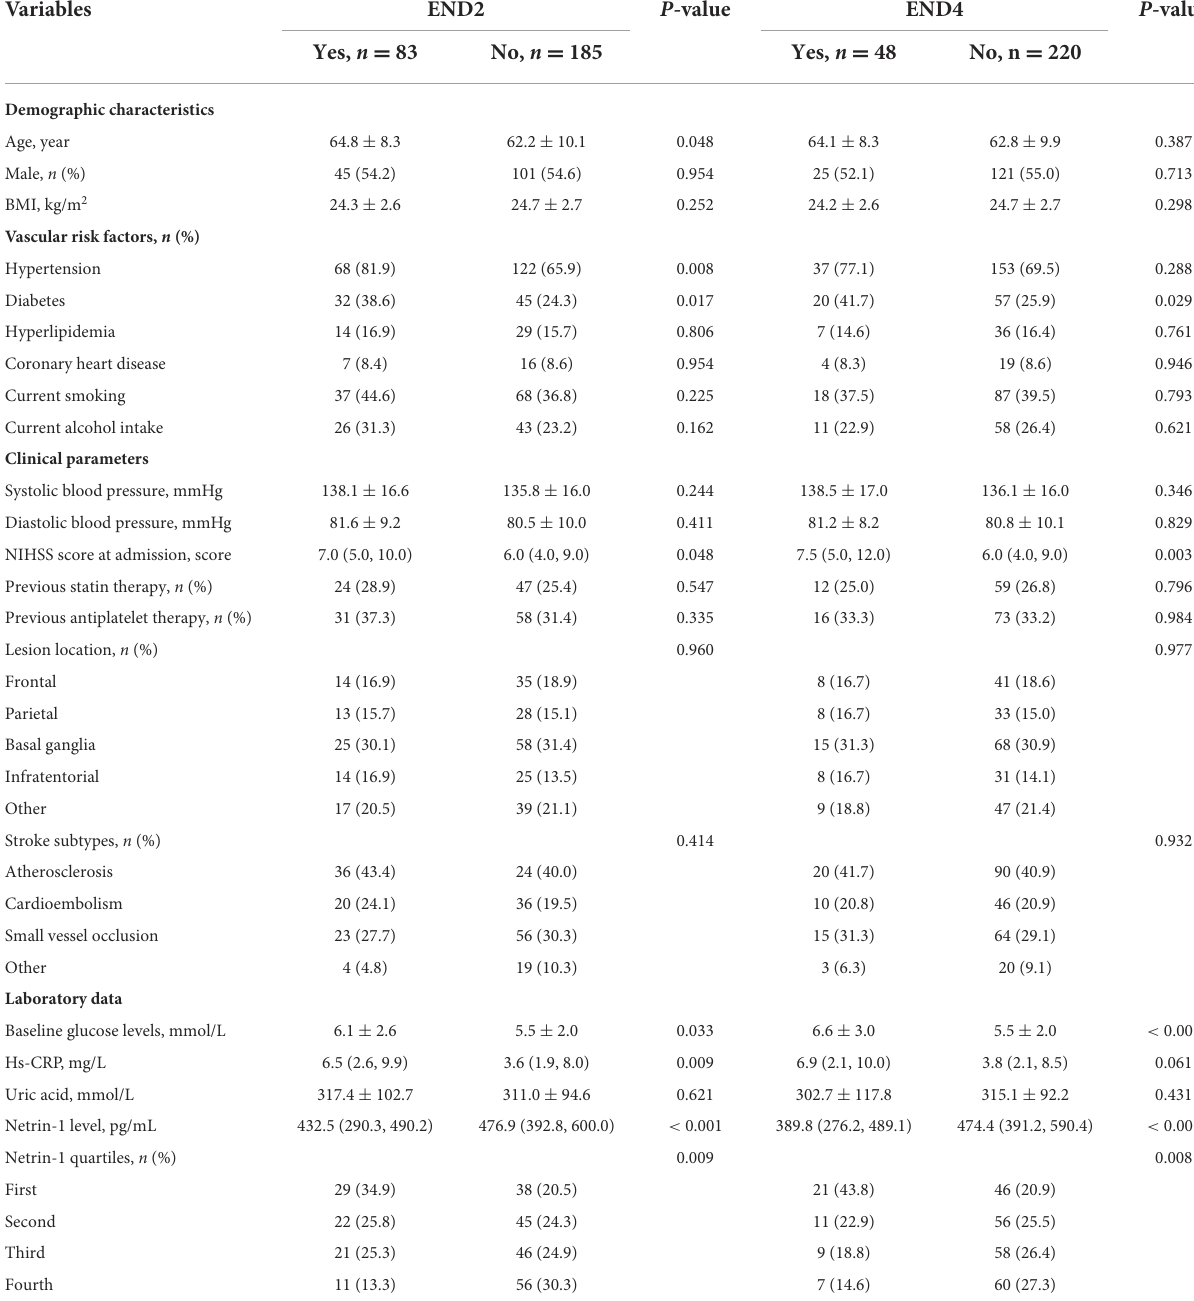
TABLE 2 Univariate analysis of the factors with early neurological deterioration.